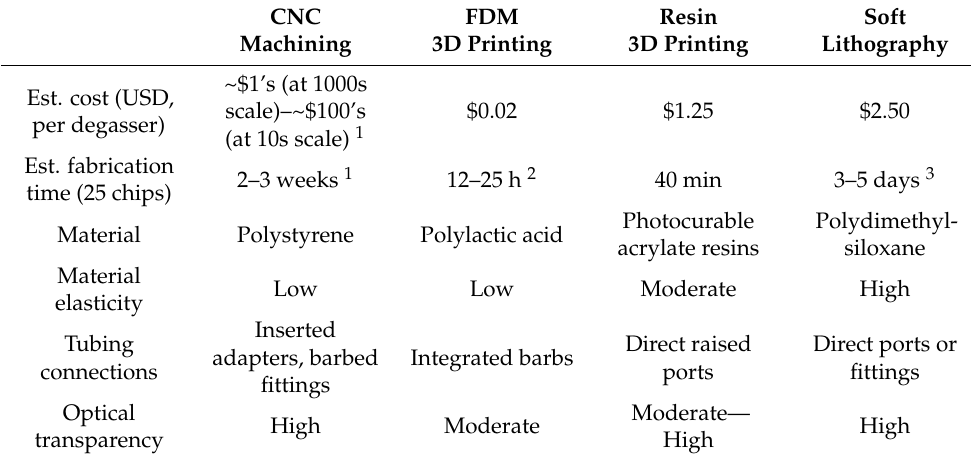
Table 1. Comparison of Bubble Trap Fabrication